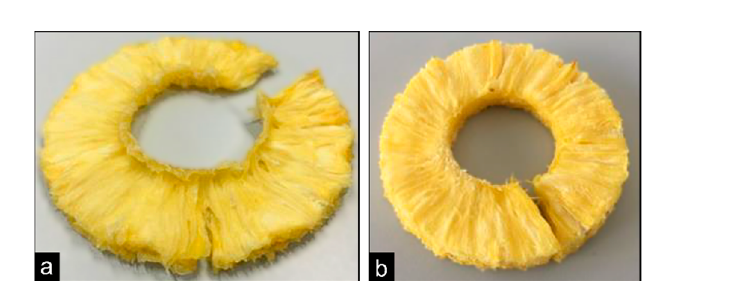
Figure 7. Effects of individual input factors, A, B, and C, and their interactions, AB, AC, BC, and ABC .